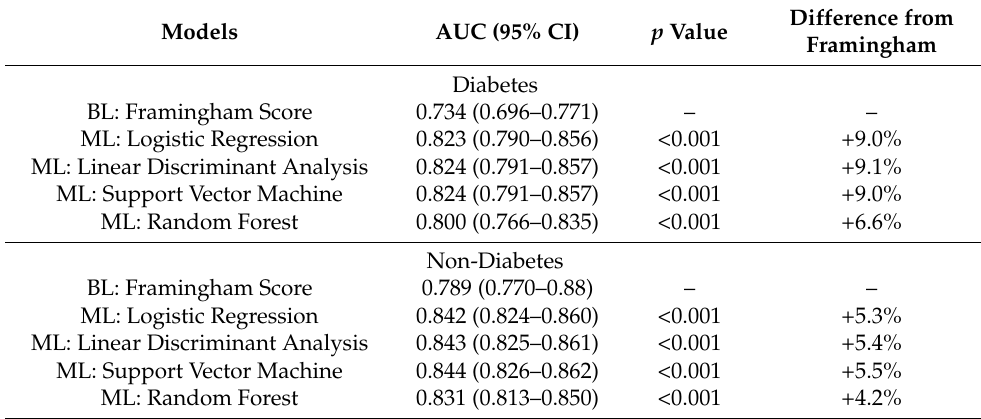
Table 8. Two-fold cross validation: Comparison of the performance of Framingham Score (baseline model (BL)) and four machine learning (ML) models predicting 15-year risk of CVD mortality